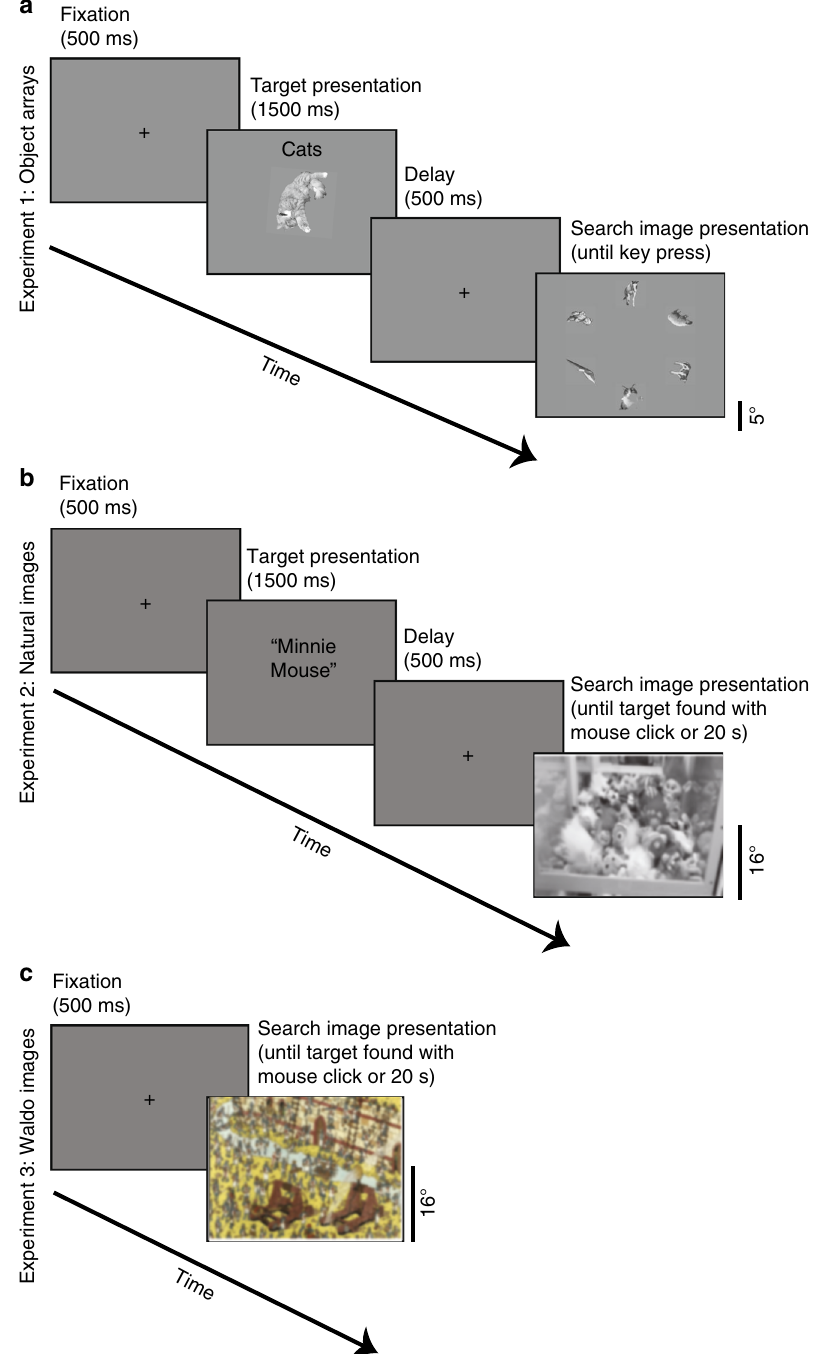
Fig. 1 Schematic description of the three tasks. a Experiment 1 (Object arrays). b Experiment 2 (Natural images). c Experiment 3 (Waldo images). All tasks started with a 500 ms fi xation period. Experiments 1 and 2 were followed by presentation of the target object for 1500 ms. In Experiment 1, the target object appeared at a random 2D rotation and the category descriptor was also shown to emphasize that subjects had to invariantly search for a different exemplar of the corresponding category shown at a different rotation. In Experiment 2, the target object was also different from the rendering in the search image. The target object (Waldo) was not shown in every trial in Experiment 3. In Experiments 1 and 2, there was an additional 500 ms delay after the target object presentation. Finally, the search image was presented and subjects had to move their eyes until they found the target. In Experiments 2 and 3, subjects also had to use the computer mouse to click on the target location. Due to copyright, in this and subsequent fi gures, all the search images were distorted by blurring. Due to copyright, we replaced the picture of a cat in a used in the experiment with a similar picture of a cat. Due to copyright, in b , during target presentation we replaced the picture used in the actual experiment with the text “ Minnie Mouse ” . As noted under “ Data availability ” , we made all the data including original images publicly available for research